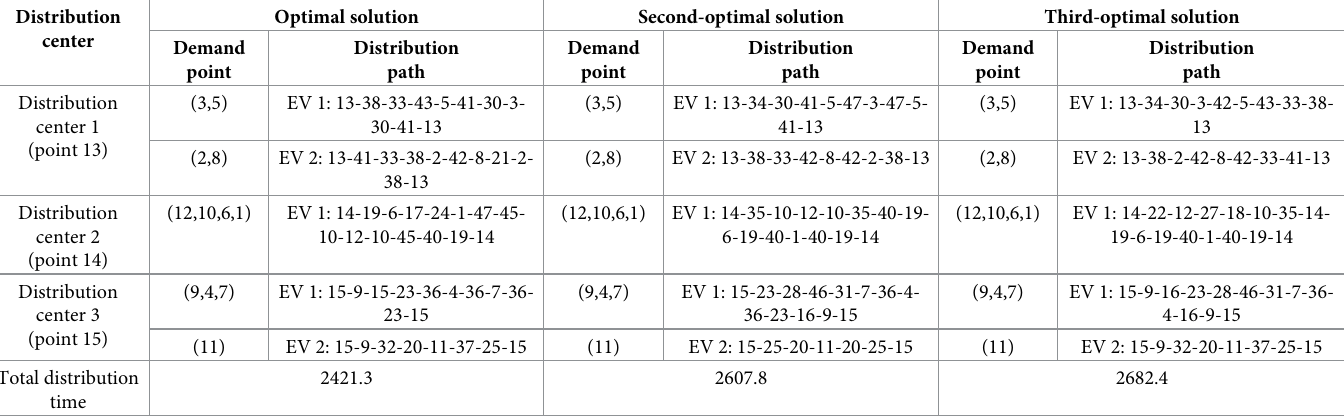
Table 4. Solution set when T = 50 .